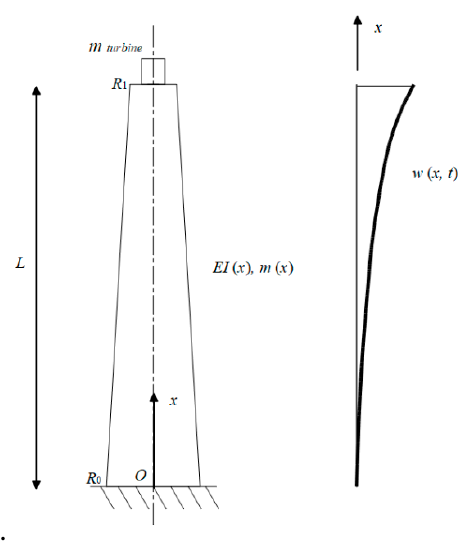
Figure 3. Continuous VAWT system that is modeled as a cantilever beam with a concentrated mass at its top.